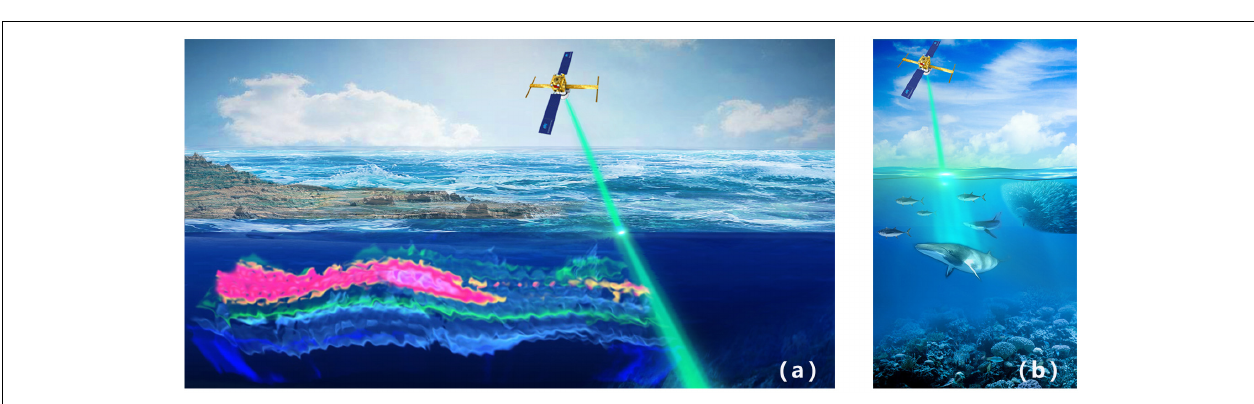
FIGURE 2 | (a) Schematic of thermocline profiled by a spaceborne ocean lidar. (b) Schematic of fish school detected by a spaceborne ocean